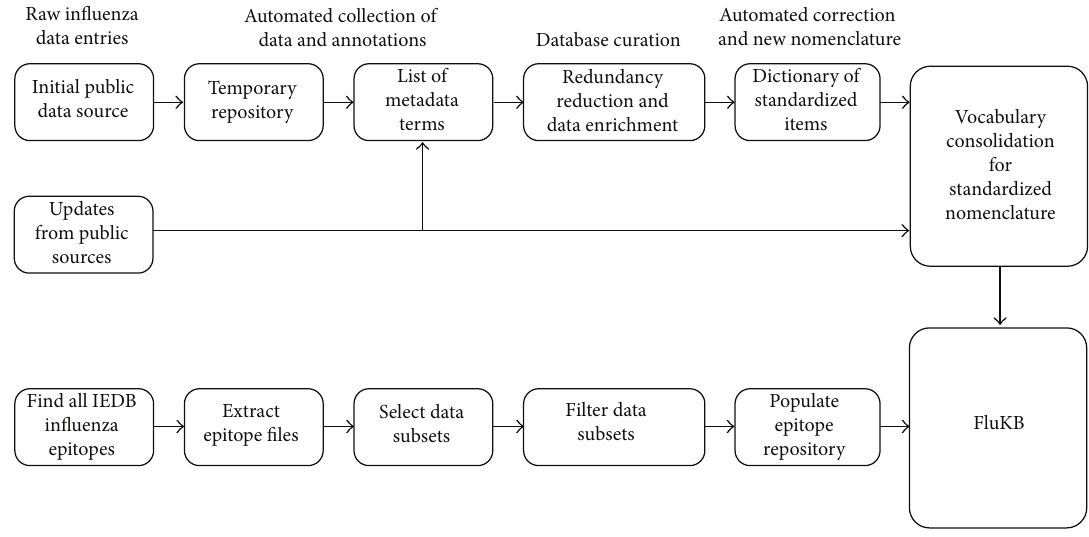
Figure 2: Semiautomated generation and updating of protein sequence repository of FluKB (upper path) and data extraction and repository creation of the influenza specific epitopes from IEDB (lower